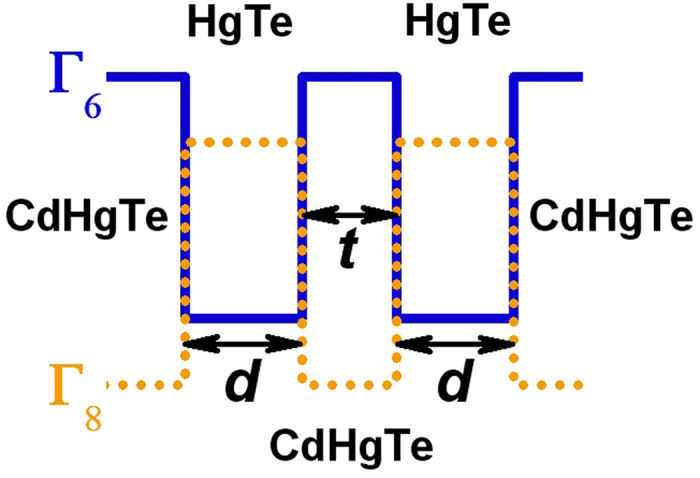
Schematic representation of the double HgTe/CdHgTe QW.Here d is the thickness of HgTe layers and t is the middle barrier thickness. Further, we consider the double QW grown on CdTe buffer in (001) crystallographic direction. The concentration of mercury in the top, middle and lower barriers is assumed to be equal to 0.378.